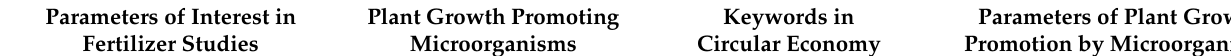
Table 4. Some of the terms allocated into clusters based on mapping of textual data.